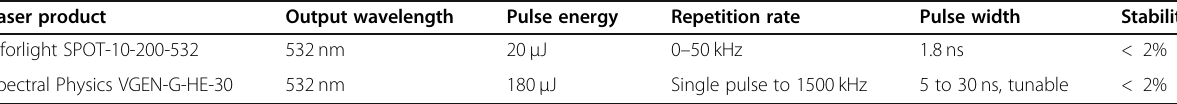
Table 2 Performances of a solid-state laser and a fiber laser for PAM